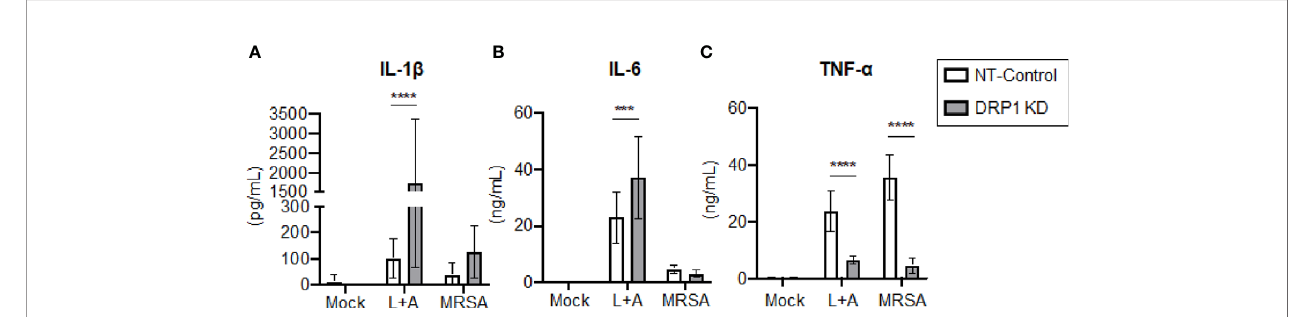
FIGURE 3 | DRP1 blocks IL-1 b and promotes TNF- a production during MRSA infection and sterile in fl ammation. Levels of IL-1 b (A) , IL-6 (B) and TNF- a (C) in culture media of NT-Control and DRP1 KD macrophages were quanti fi ed by ELISA at 24h post stimulation. Macrophages was left untreated (Mock), stimulated with 200 ng/ml of LPS for 23h followed by 1 mM of ATP for 1h (L+A), or infected with MRSA (MOI 20). Graphs indicate the mean of n ≥ 4 independent experiments ± SD. Statistical analysis was performed by two-way ANOVA followed by Sidak ’ s multiple comparisons test. *** P < 001; **** P <